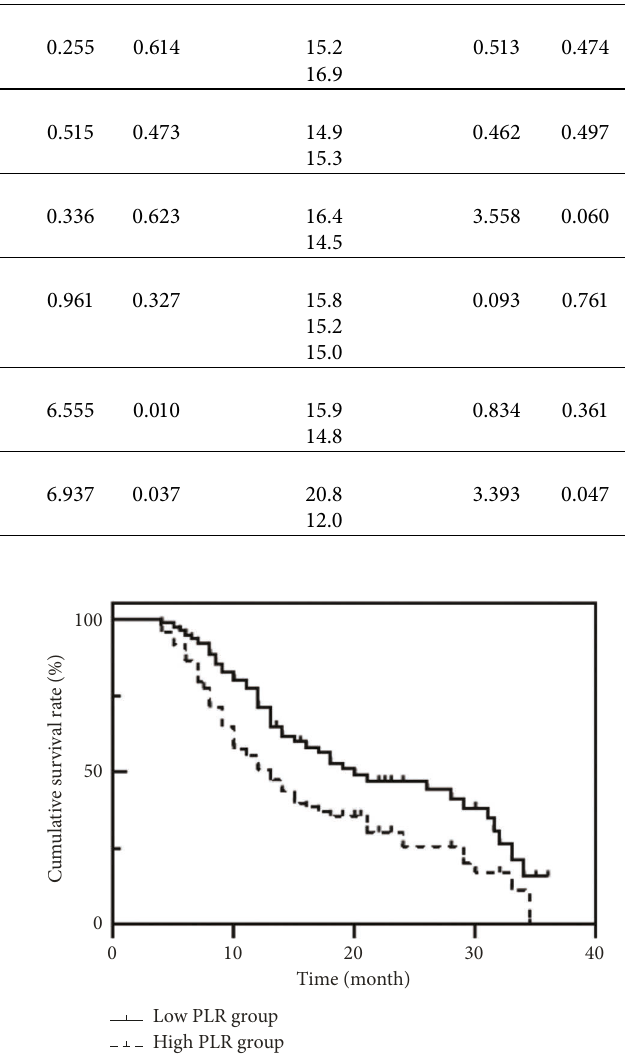
Figure 2: Survival curves of patients with different PLR